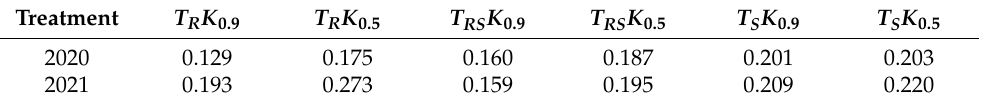
Table 3. Results of NRMSE statistics for simulated and measured values of NRLD.